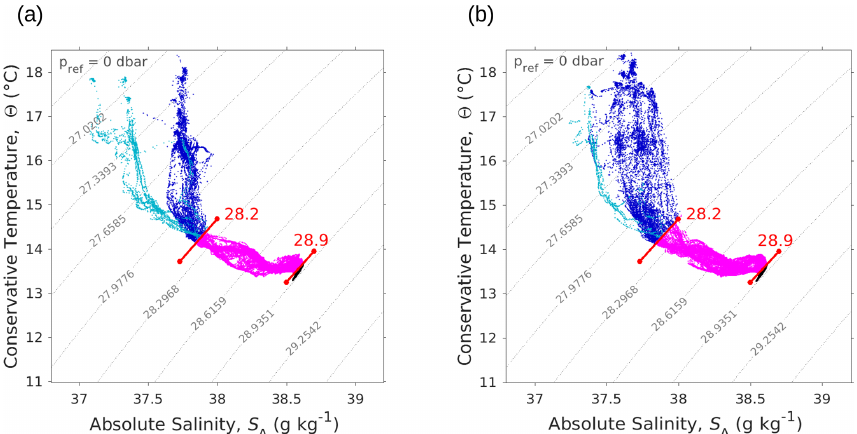
Figure A3. (cid:50) – S A diagrams measured by the SeaExplorer glider along the outward route (a) 6 May 2018 at 00:00–9 May 2018 at 21:00UTC and the return route (b) 10 May 2018 at 00:00–13 May 2018 at 21:00UTC. As in Fig. 4, the younger AW is represented in light blue, whereas the older AW is represented in dark blue. Intermediate water and deeper water are represented in pink and black, respectively. The isopycnals 28.2 and 28.9kgm − 3 , separating surface waters from deeper water, are also